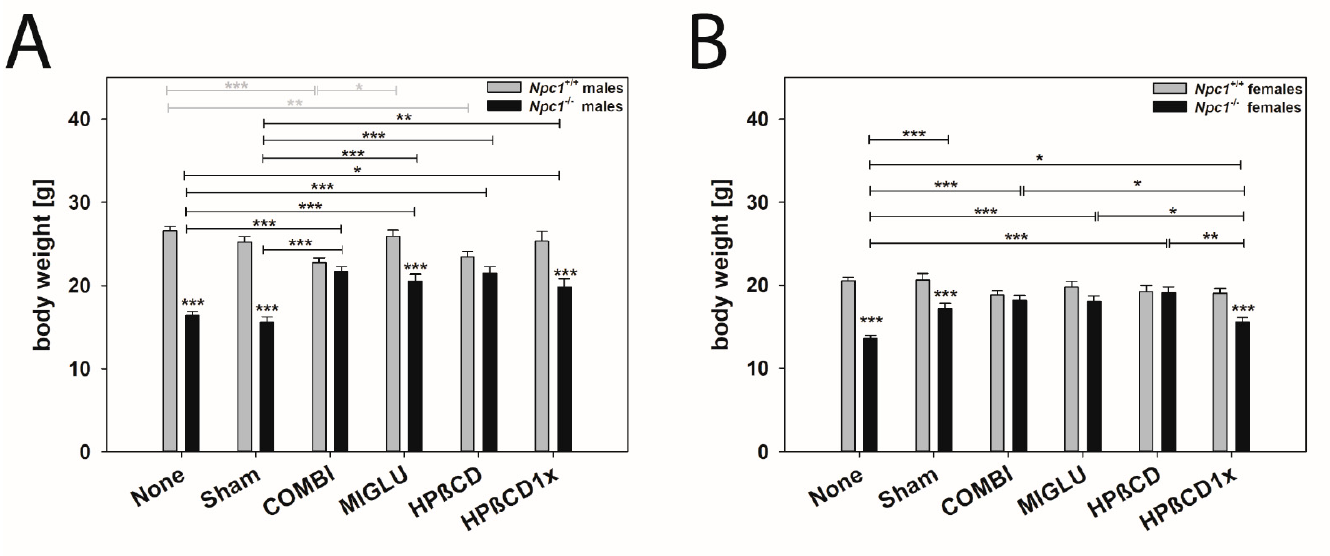
Figure 1. Body weight of male ( A ) and female ( B ) Npc1 mice. Significant post-hoc tests are indicated by asterisks (* p < 0.05, ** p < 0.01, *** p < 0.001). Data are means ± SEM. Female mice: The body weights of the female Npc1 +/+ mice of groups None (20.56 ± 0.36 g), Sham (20.64 ± 0.76 g), COMBI (18.819 ± 0.51 g), MIGLU ( 19.75 ± 0.72 g),